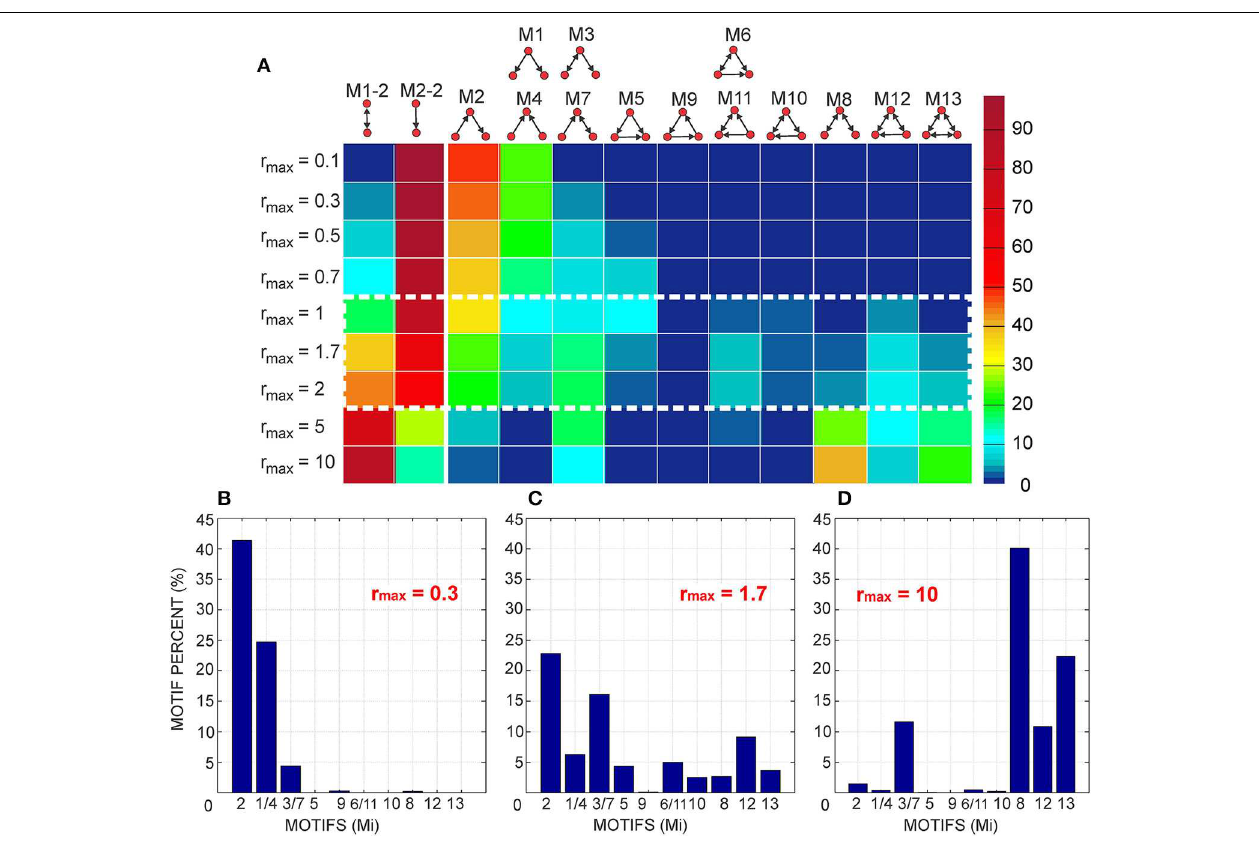
FIGURE 7 | The expected motif counts normalized with the total number of the same-size motifs. (A) The expected motif counts obtained for a wide range of values for the normalized effective radius ( r max ) . The color code on the right 0 . 1 , 0 . 3 , 0 . 5 , 0 . 7 , 1 , 1 . 7 , 2 , 5 , 10 ∈ { } shows the percentages of different motifs in the total number of the same-size motifs. The left part of the panel (columns one and two) corresponds to the 2-node motifs, while the right part of the panel illustrates the 3-node motifs. The middle range of the values for r max (encircled with the